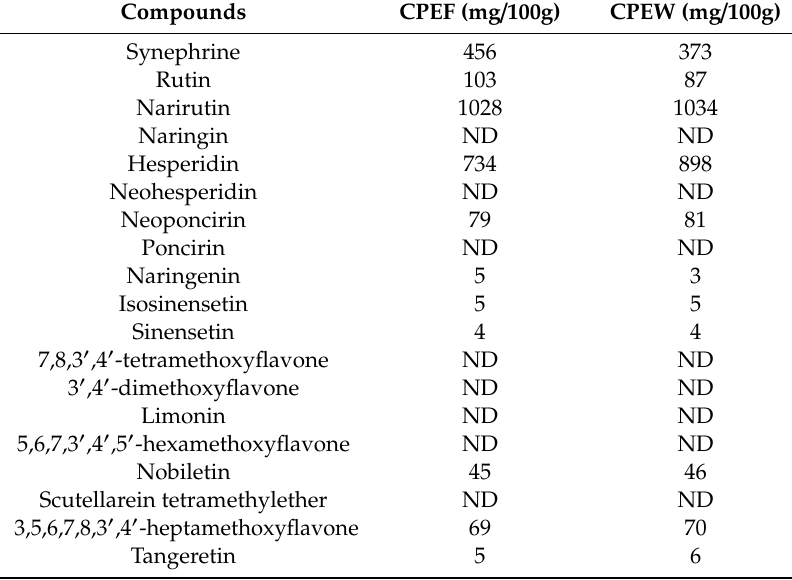
Table 1. Components of the Citrus peel extract.